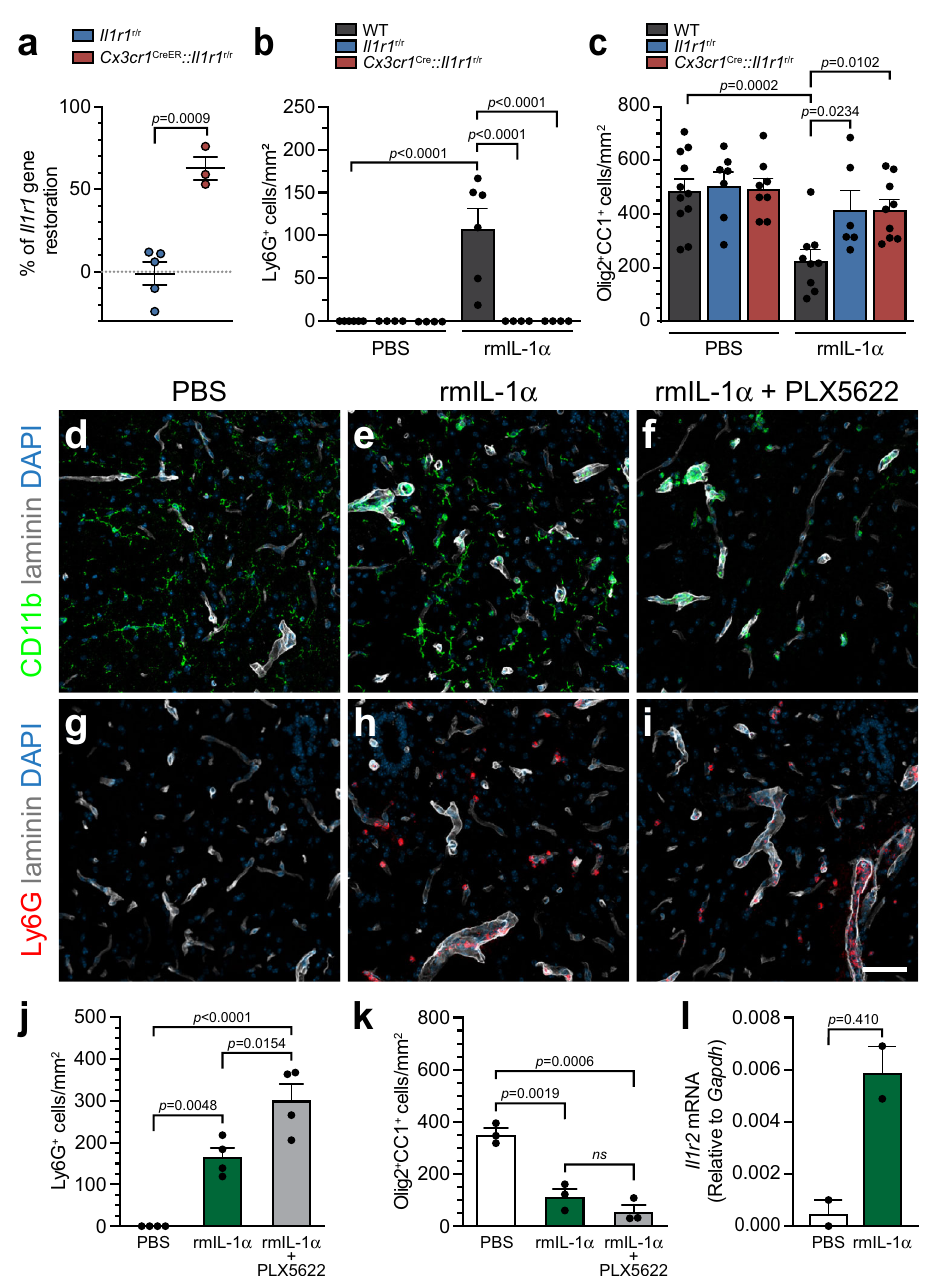
Fig. 6 | Microglia alleviate IL-1 α -mediated neuroin fl ammation and oligoden- drocyte loss independently of their expression of IL-1R1. a Quanti fi cation of restoration of Il1r1 gene expression in primary microglia isolated from the unin- juredspinalcordofadult Il1r1 r/r miceexpressinganIL-1R1-knockoutphenotype(set to0%)and Cx3cr1 CreER :: Il1r1 r/r miceat30dayspost-tamoxifentreatment( n =5 Il1r1 r/r